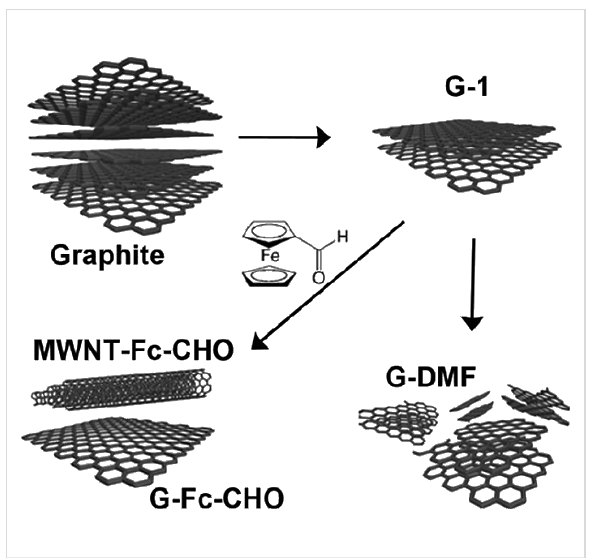
Figure 3: Ultrasound-assisted synthesis of MWNTs from graphite upon the addition of ferrocene aldehyde . Reprinted with permission from [30], copyright 2012 American Chemical